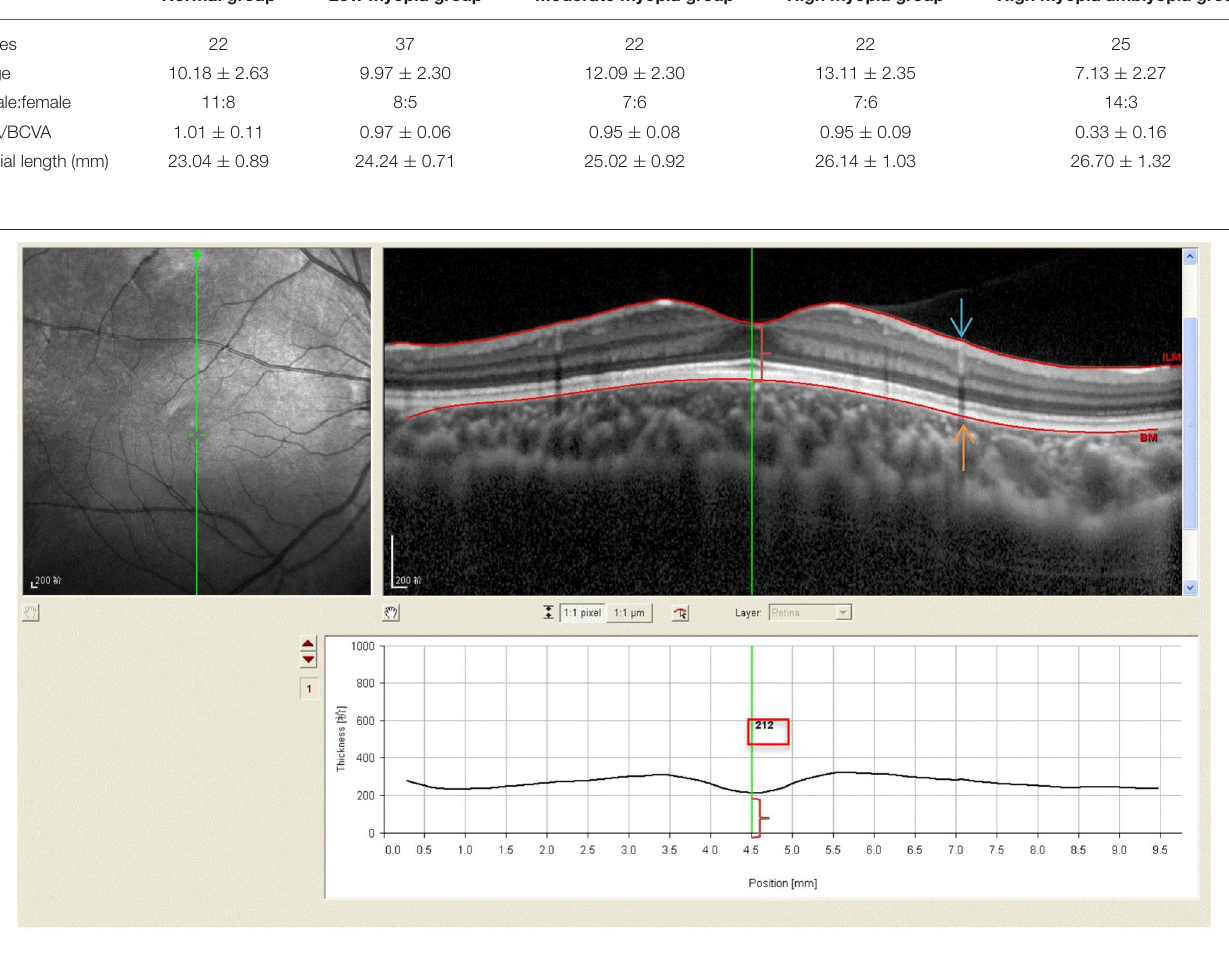
FIGURE 1 | Spectral-domain optical coherence tomography (SD-OCT) scans showing retinal thickness of high myopic amblyopic eyes. (Top left) Fundus image showing vertical scan lines go through the fovea in 6-year-old subject. (Top right) The retinal thickness (red brace) was defined from ILM (redline, blue arrow) to the basal aspect of the RPE (redline, yellow arrow). (Bottom) The retinal thickness 212 µ m (red brace, red boxes) was measured vertically at the subfoveal by Heidelberg own software, and at 500 µ m intervals from the fovea to 3mm superior,